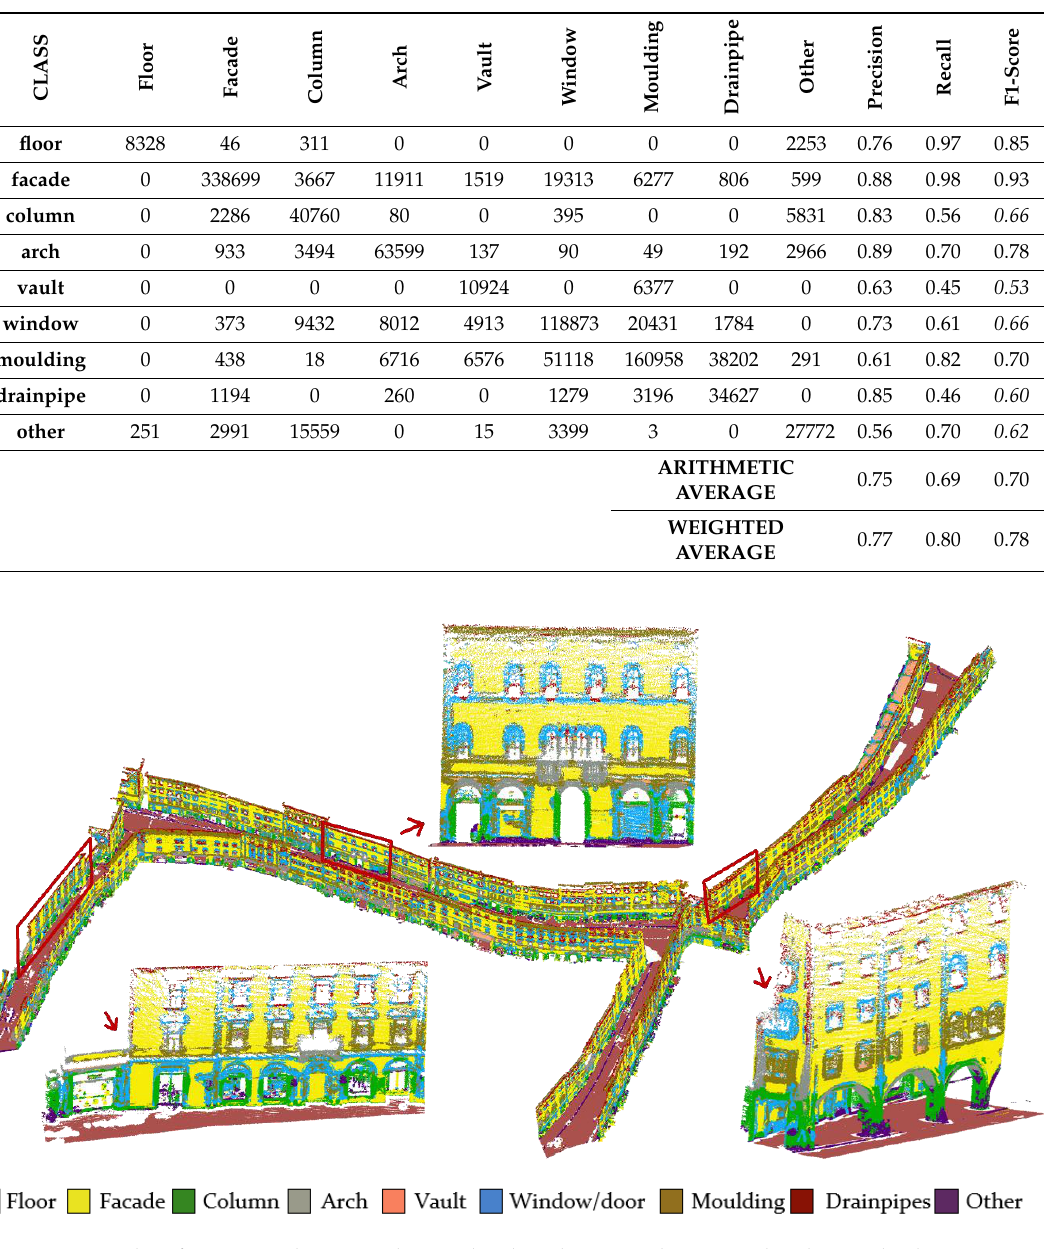
Figure 11. Classification results: generalisation level #4, dataset F. Please note that despite the decreasing spatial resolution from ground to top, the generalisation could work.